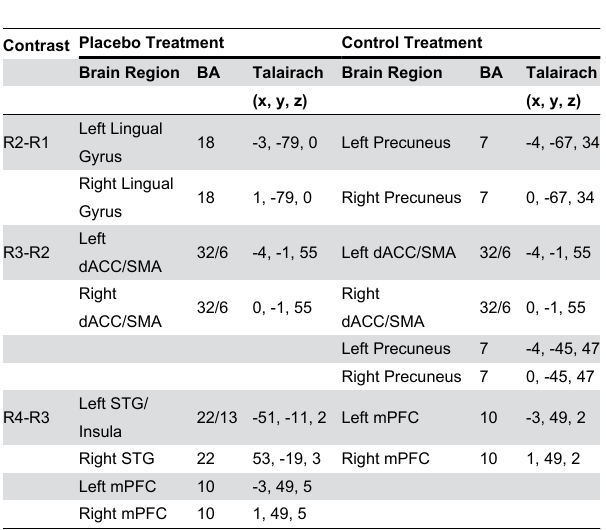
Table 3. Brain regions seen in the source localisation